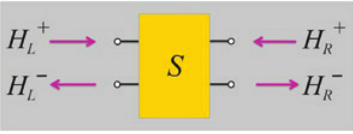
Figure 1: Scattering matrix S of a two-port optical system. + H and + H are the complex magnetic field amplitudes of the L R incoming modes at the left and right ports, respectively. Similarly, − H are the complex magnetic field amplitudes of the H and − R L outgoing modes from the left and right ports,